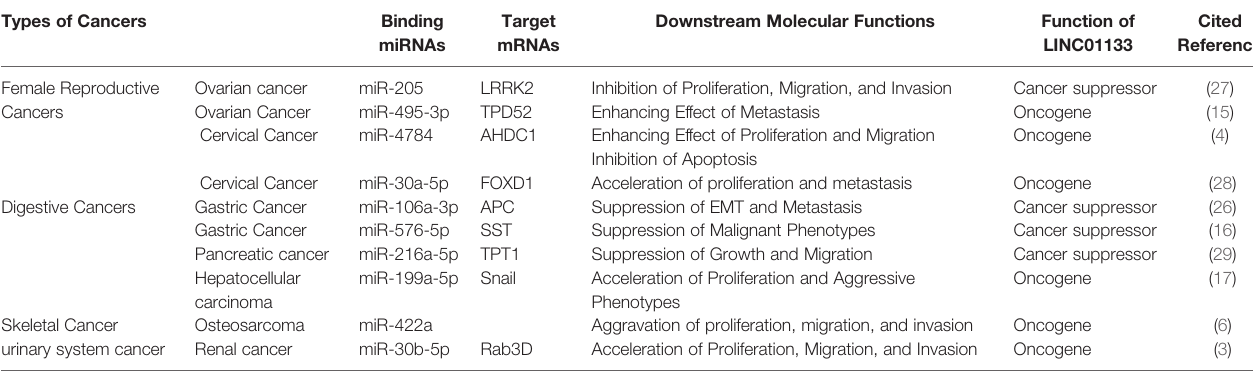
TABLE 1 | The ceRNA mechanism of LINC01133 in